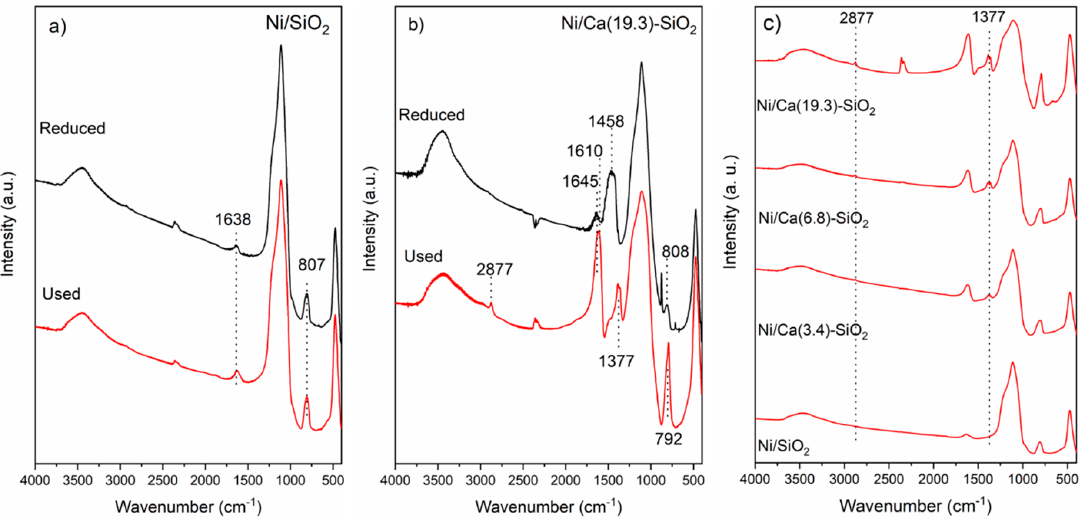
Figure 10. Fourier transform infrared spectroscopy (FTIR) spectra of ( a ) reduced and used Ni/SiO 2 ; ( b ) reduced and used Ni/Ca(19.3)-SiO 2 ; and ( c ) used Ni/Ca(X)-SiO 2 catalysts. For all the samples, the fingerprints of SiO 2 at 475, 805, and 1115 cm − 1 related to the Si-O-Si, Si-